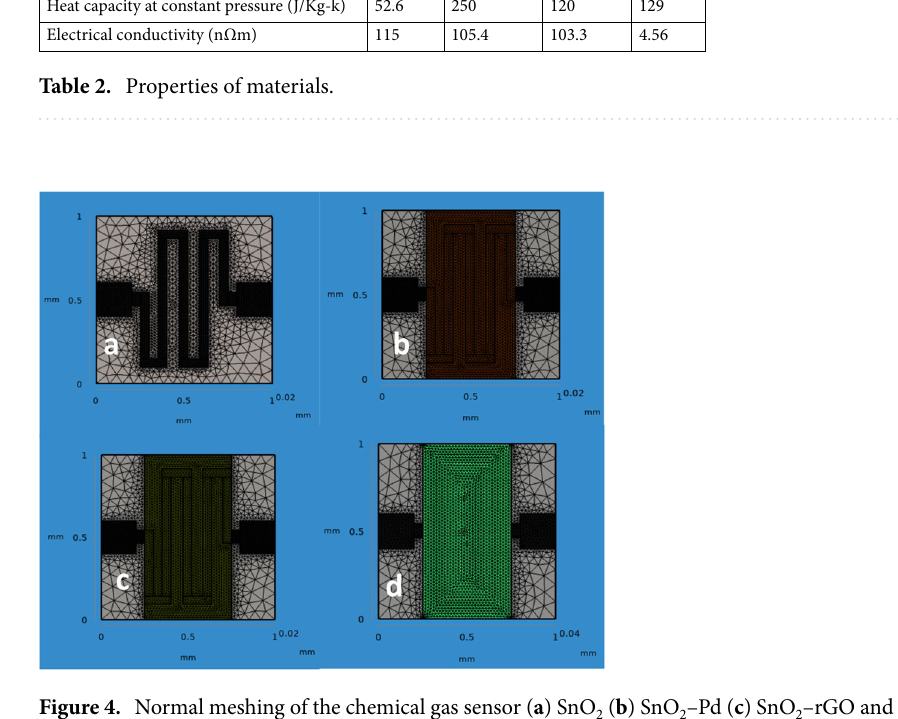
Figure 4. Normal meshing of the chemical gas sensor ( a ) SnO 2 ( b ) SnO 2 –Pd ( c ) SnO 2 –rGO and ( d ) SnO 2 –Pd/